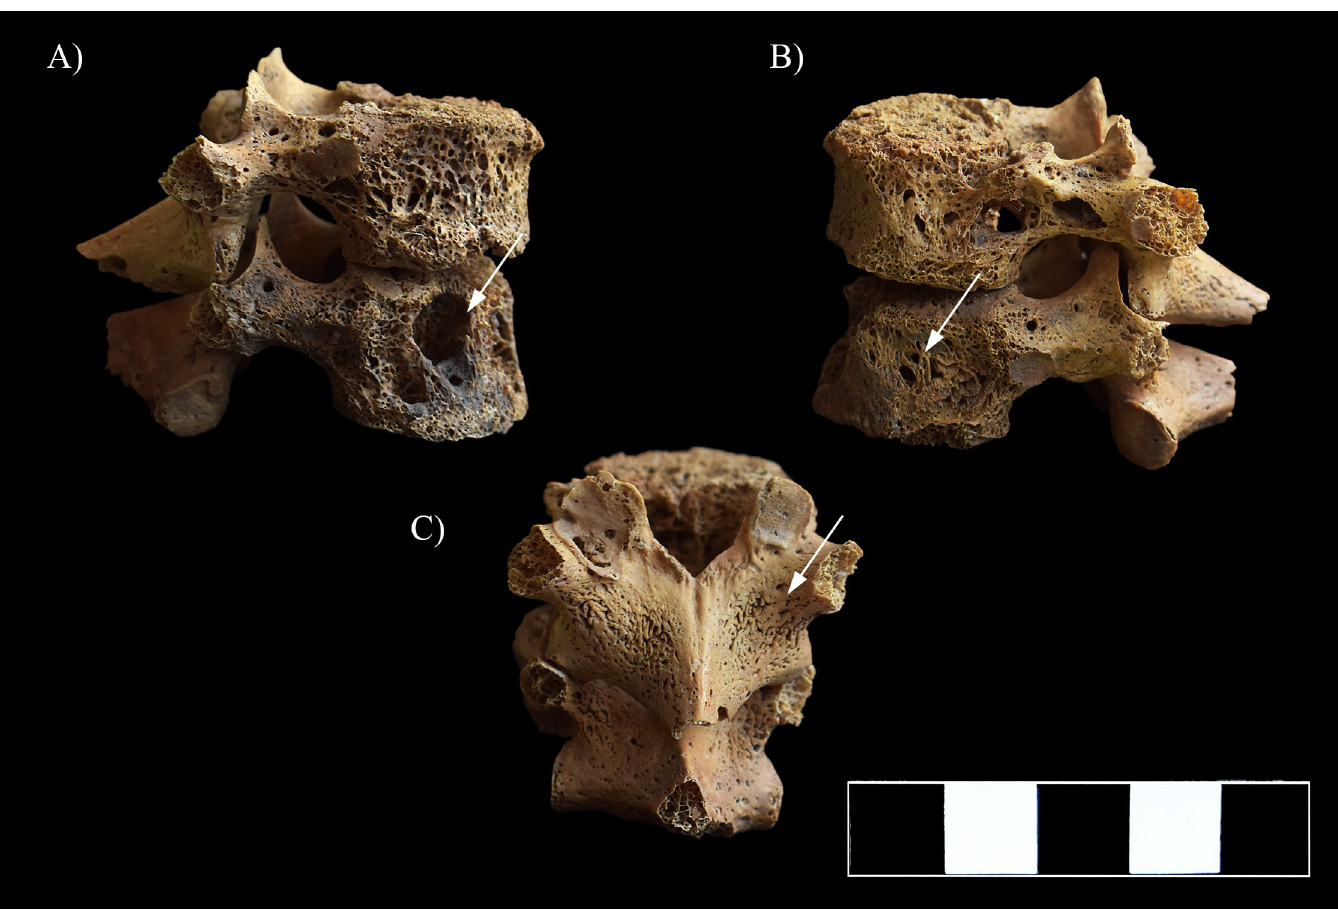
Fig 8. Multiple, well-circumscribed osteolytic lesions, cortical remodeling, and signs of hypervascularization in the T11–12 vertebrae (white arrows). A) Lateral view (right side), B) Lateral view (left side), and C) Posterior view.